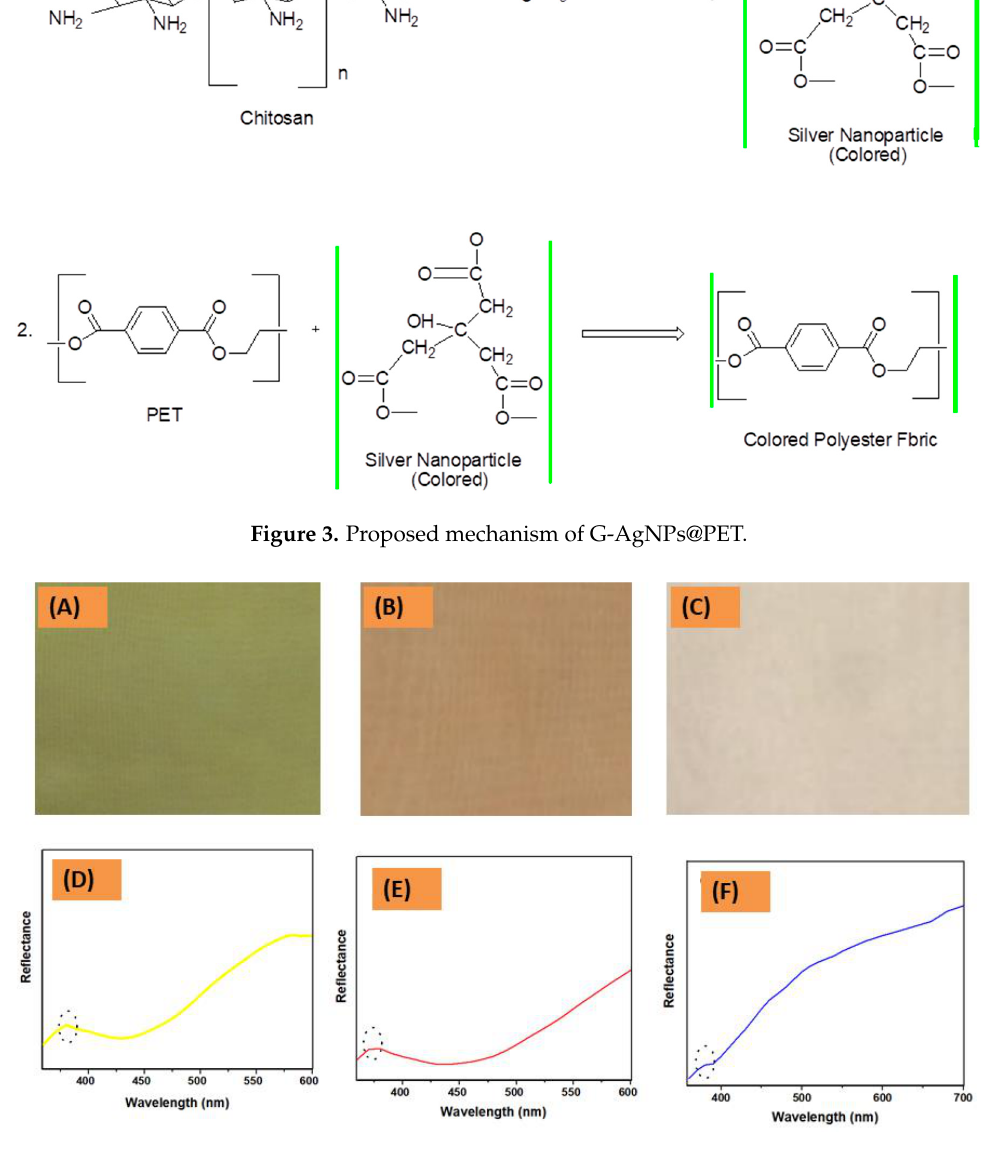
Figure 4. ( A – C ) Photographs; and ( D – F ) reflectance curves of the colored fabric.